Question: In one sentence, what is this figure communicating?
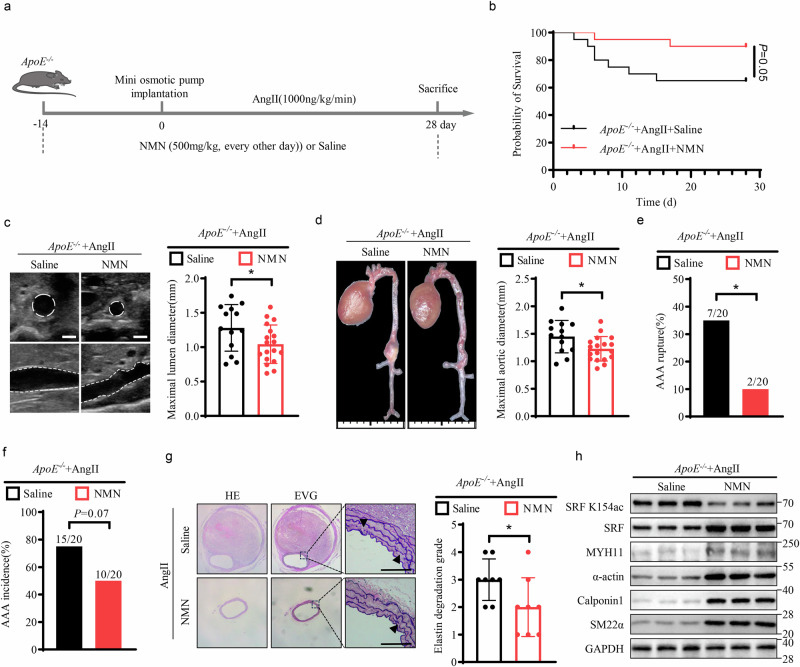
Answer: SIRT7 activation by NMN supplementation protects against aortic aneurysm formation in mice. a Schematic diagram of the angiotensin II (AngII)-induced abdominal aortic aneurysm (AAA) model in ApoE −/− mice administrated with saline or nicotinamide mononucleotide (NMN). b Survival curves of AngII-induced AAA in indicated groups. n = 20 per group. c Representative ultrasonic images and quantitative comparison of maximal lumen diameter in AngII-induced mice after NMN administration. n = 13 for saline and n = 18 for NMN. Scale bar, 1 mm. d Representative macroscopic images and quantitative comparison of maximal aortic diameter in AngII-induced mice after NMN administration. n = 13 for saline and n = 18 for NMN. e The rupture rate of AngII-induced AAA in indicated groups. n = 20 per group. f The incidence of AngII-induced AAA in indicated groups. n = 20 per group. g Representative hematoxylin and eosin (HE) and VVG staining images and quantitative comparison of VVG staining score in AngII-induced mice after NMN administration. n = 8. Scale bar, 100 μm. h Aortic tissues from AngII-induced mice after NMN administration were collected for western blotting analysis. n = 3. Data are expressed as mean ± SD. b Kaplan–Meier method followed by log-rank tests. c , d , g Two-tailed paired Student’s t test. e , f Fisher exact test. SIRT7, sirtuin 7.